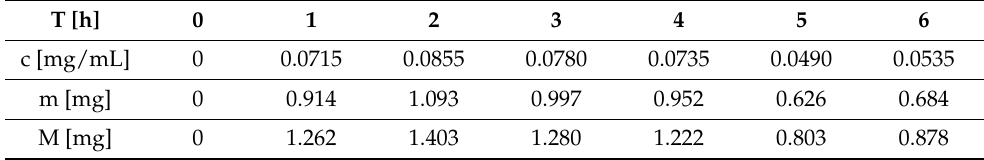
Table 1. In-vivo concentrations and amounts of the drug without (m) and with (M) tenside. T